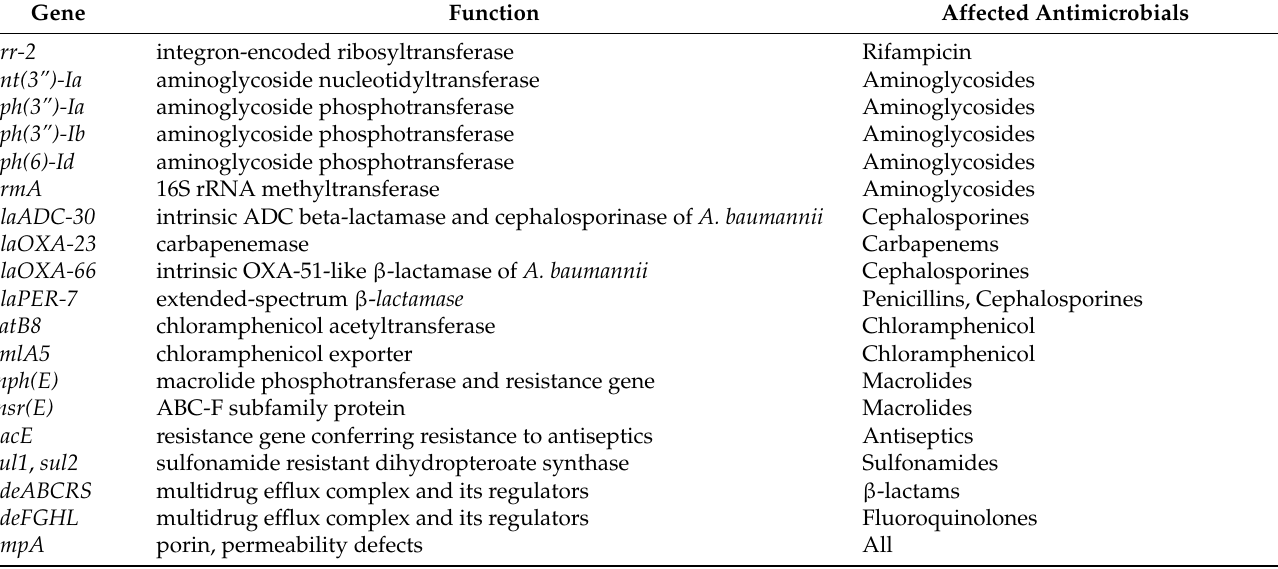
Table 2. Antibiotic resistance genotype of A. baumannii isolates.